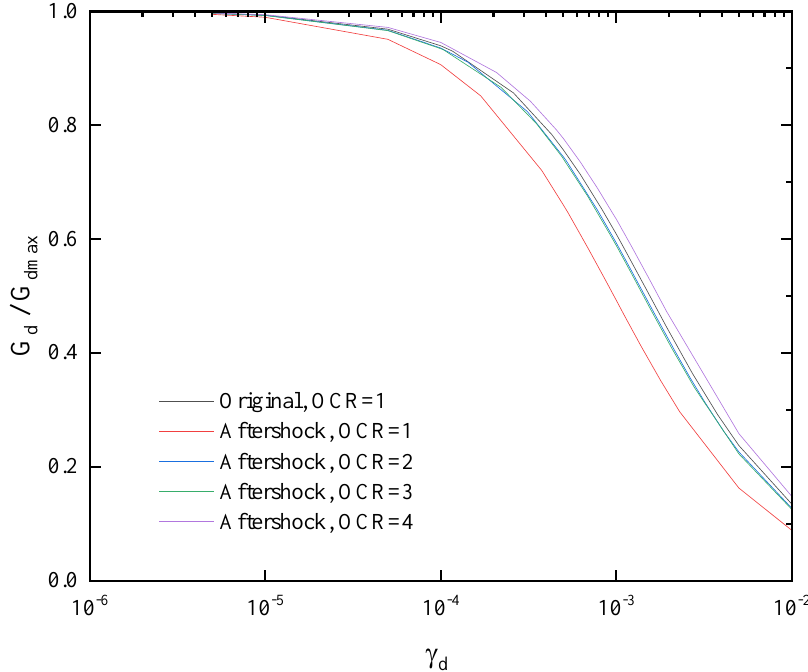
Figure 9. Curves of the dynamic shear modulus ratio versus dynamic shear strain of the saturated loess under different test conditions.